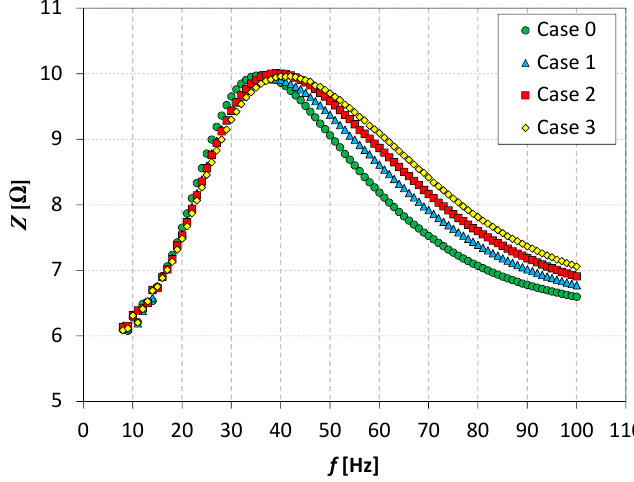
Figure 3. The impedance of SJA as a function of frequency at real power p = 3 W. The averaged and maximum velocity of SJs in the centerline at the distance of x / d = 0 is shown in Figure 4. The highest time-averaged velocity was obtained in Case 0 for the circular orifice and was even about 12–15% higher than in the other cases with chevron orifices at the natural frequency. The significant decrease in average velocity was surprising, especially because the difference in the case of chevron orifices was not big and was obtained at about 1% at the natural frequency. Generally, the larger the chevron cutouts in the orifice, the smaller the time-average velocities for frequencies lower than 50 Hz. The maximum velocity of SJs has a reverse trend to averaged velocity; the larger the chevron cutouts in the orifice, the higher the maximum velocity. It is an important dependence that shows significant differences in the flow-through and around the orifice. It is widely discussed in Section 3.2.